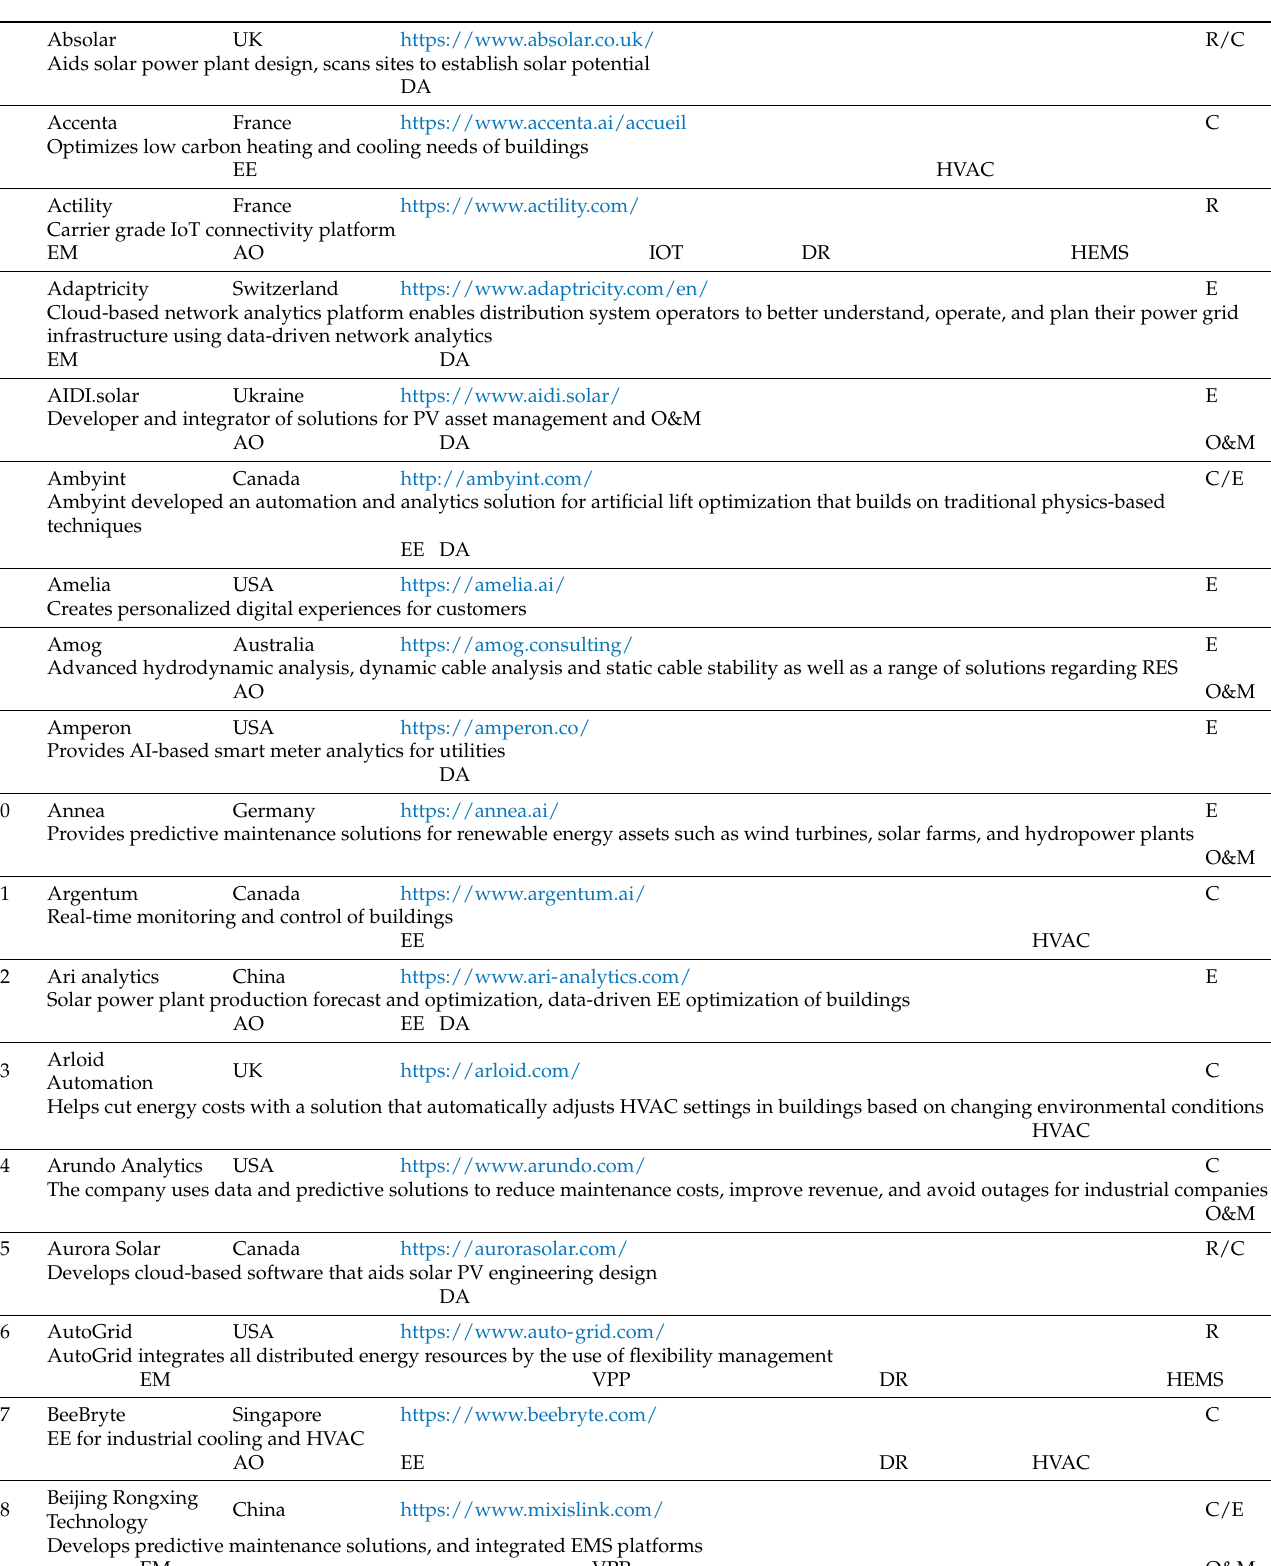
Table A1. 220 AI companies in the power sector in 2022. (websites last accessed on 5 January